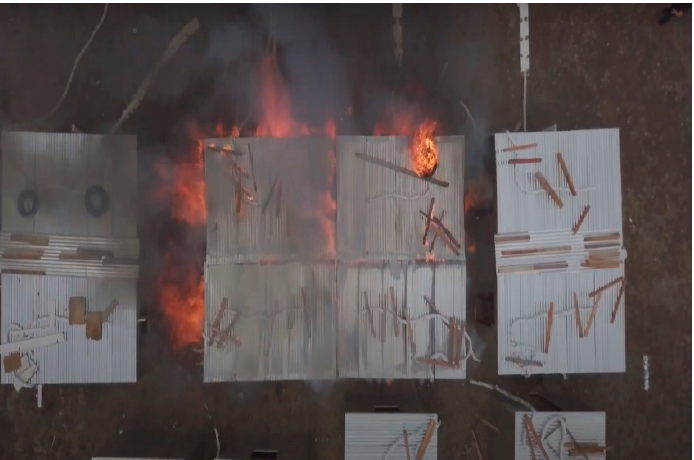
Figure 1. Large scale experiment performed via the IRIS-Fire project [2] in 2018 emphasizing the size of the external plume from vertical openings (doors and window) and leakage at joins of walls and roofs.